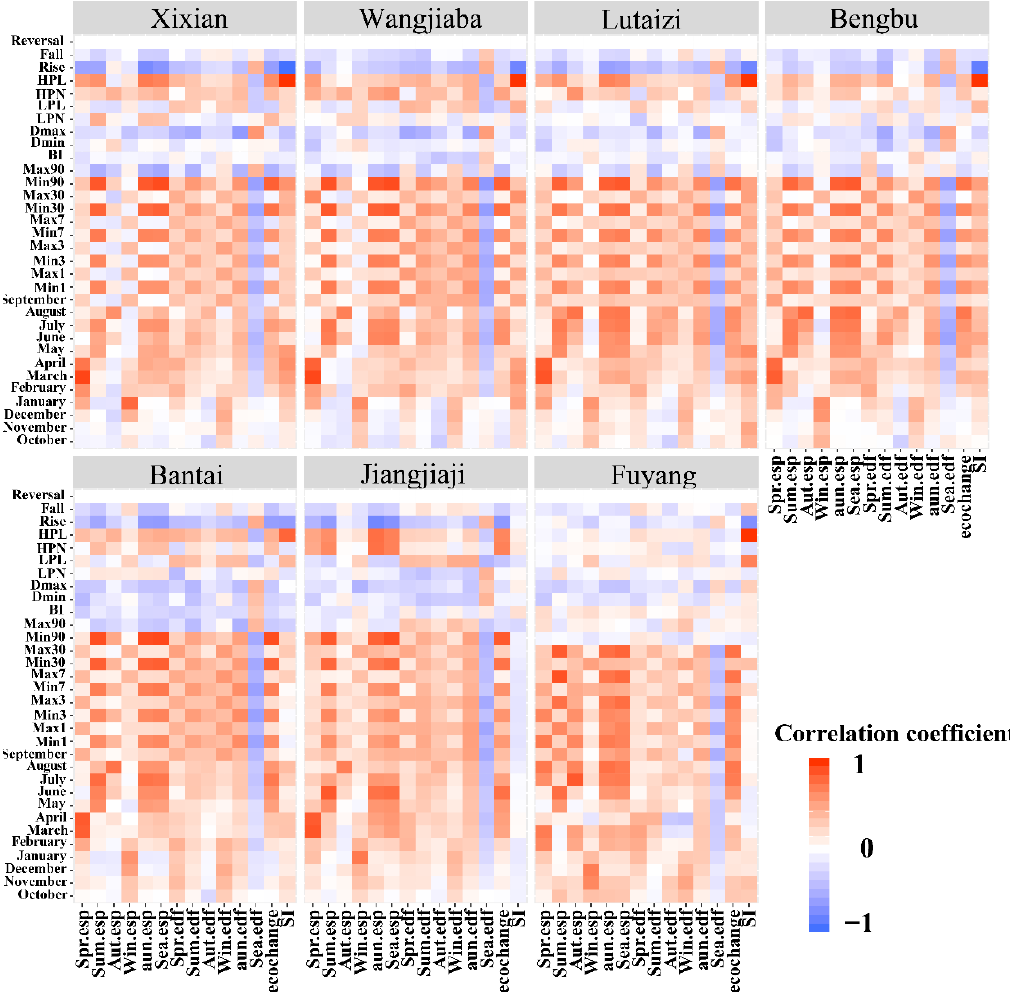
Figure 13. Correlations between ecological instream flow and IHA (Indicators of Hydrologic Alteration) in the HRB.